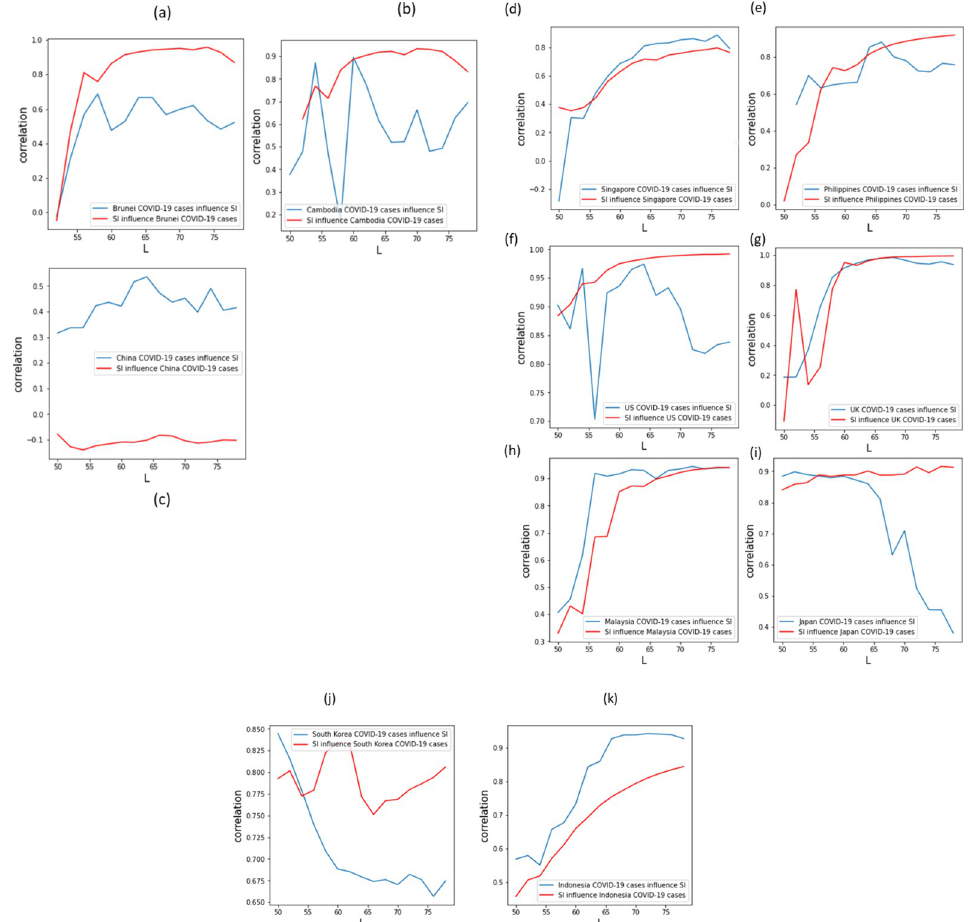
Fig 5. CCM results for COVID-19 and SI showing correlation on the y-axis and L as the time series